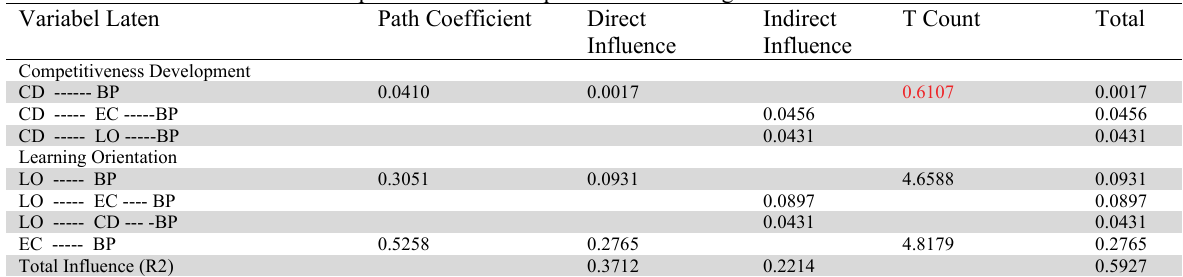
Contribution of the Influence of Competitiveness Development and Learning Orientation on Business